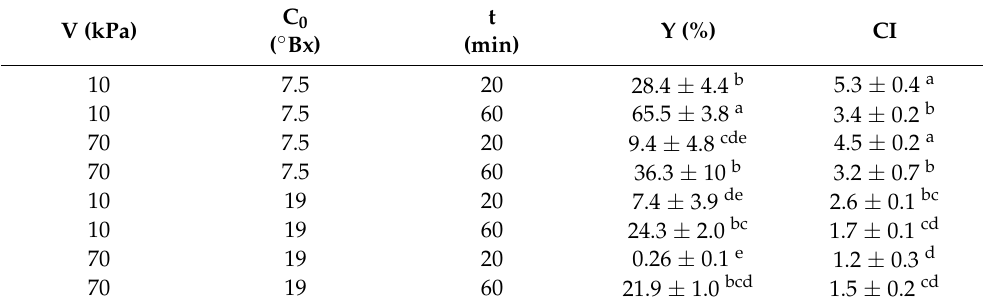
Table 2. Full Factorial Design (FFD), responses of solute yield (Y) and concentration index (CI). Within a column, different lowercase letters denote significant differences ( p < 0.05) between Y and